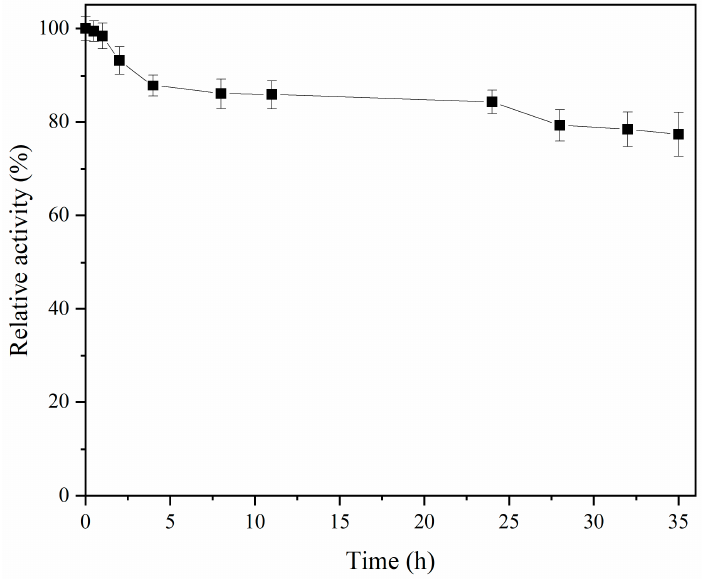
◦ C in 50 mM MES buffer at pH